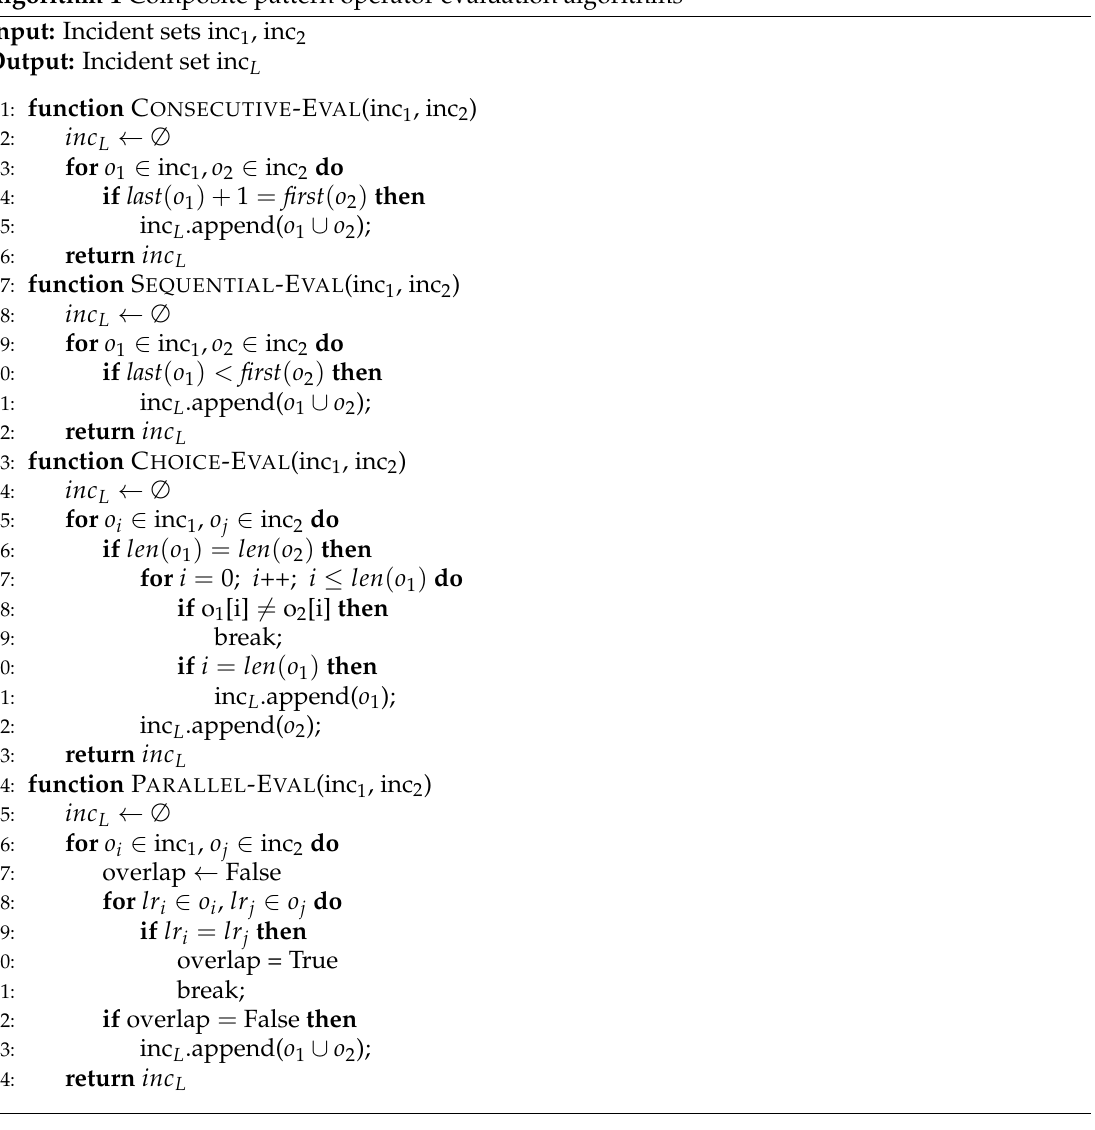
Algorithm 1 Composite pattern operator evaluation